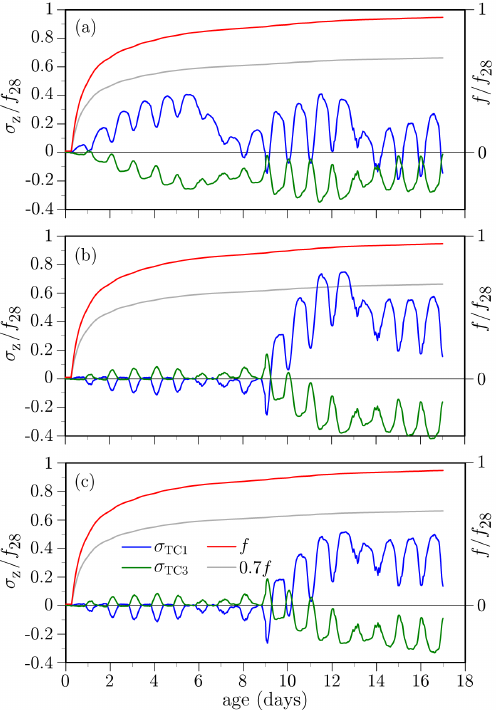
Figure 23. Simulated stresses at mid-deck location based on 28-day strain limit of 450 µ m/m: ( a ) the curing sheet is absent; ( b ) curing sheet is present; and ( c ) curing sheet and curing compound